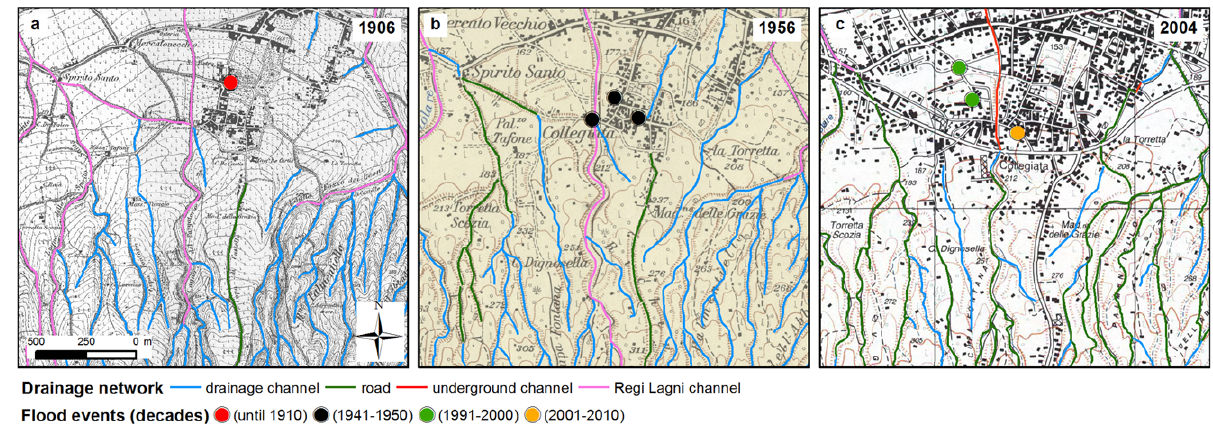
Figure 13. Hydrographical network modifications in 1906, 1956 and 2004 in the Pollena-Trocchia area. The drainage channel is in light-blue colour, the road is in dark-green, the underground channel in red and the “Regi Lagni” channels in magenta.